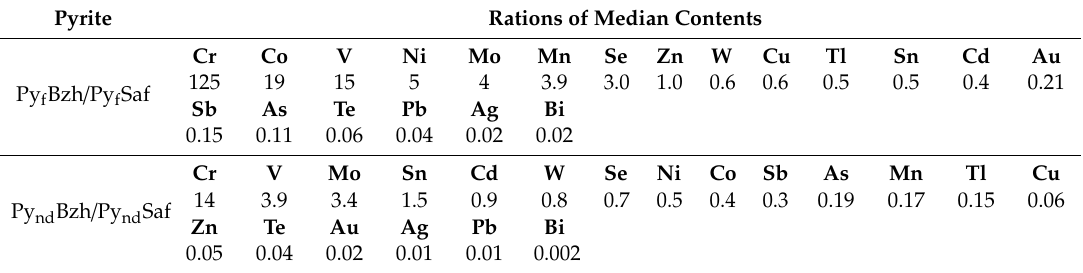
Table 6. Ranges of rations of median contents of chemical elements, calculated for framboidal (Py f ) and nodular (Py nd ) pyrite from the Bazhenov Formation (Bzh) normalized to the same pyrite varieties from the Safyanovskoe massive sulfide deposits (Saf). Pyrite Rations of Median